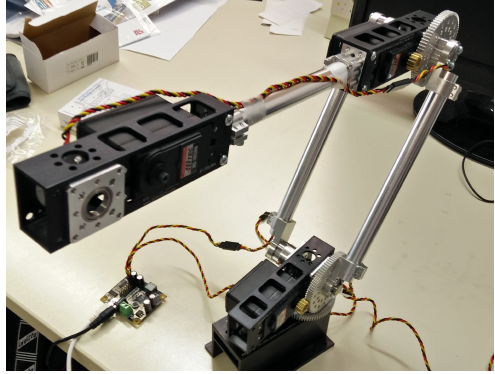
Figure 5. The roboticarmwithoutthe end-e˙ector